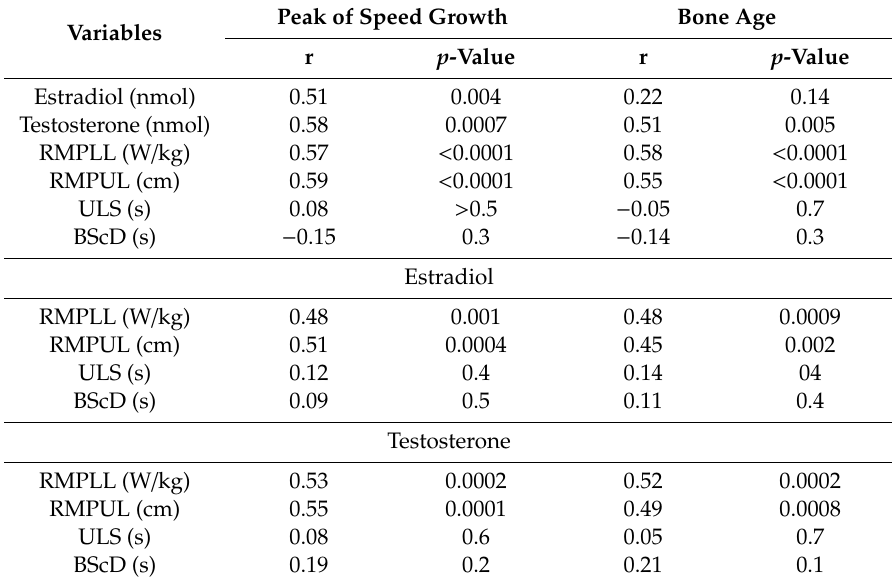
Table 3. Correlations of peak growth velocity and bone age with physical variables. Variables